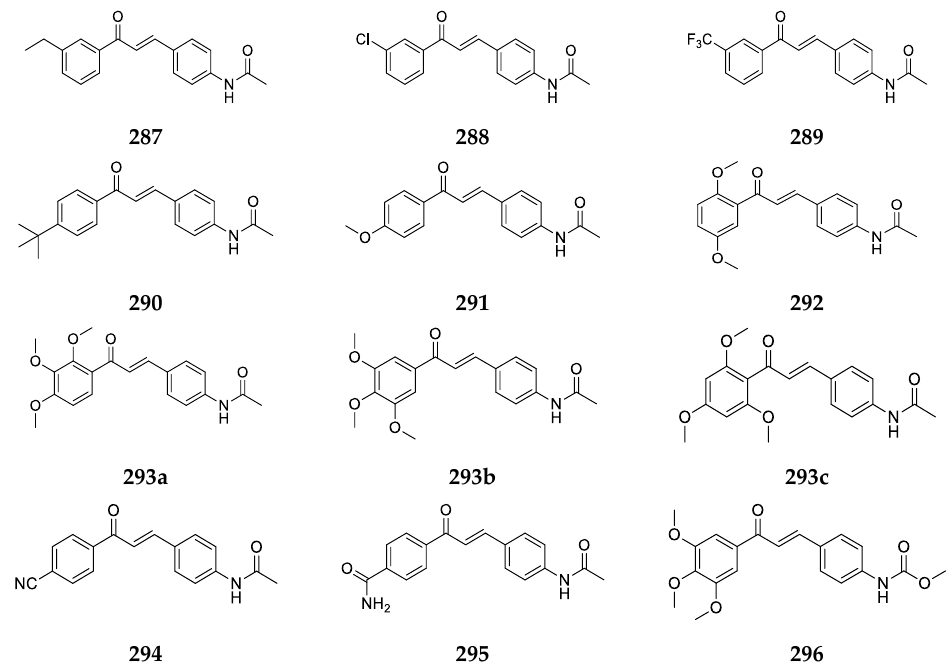
Figure 76. Chemical structure of N -acyl-4′-aminochalcone derivatives with substitution on ring A. Earlier, we have discussed -NH 2 -substituted and N -alkyl-aminochalcones from the same investigation. Similarly, the potential of compounds 287 – 296 as antimitotic agents was tested against HeLa cells. The activity of these compounds was reported as the equivalent dose (ED), which is the concentration of the compound found to be equivalent to 0.05 µg/mL colchicine. Table 35 represents the ED value of compounds 287 – 296 over 6 h [61]. Apart from the acetylation on nitrogen at position 4′, compound 62c has the same structure as 293b . Compound 62c has also been added as a reference compound in Table 35. Table 35. The concentration of compounds 287 – 296 giving the same mitotic index as colchicine (0.05 µg/mL), i.e., equivalent dose (ED) against HeLa cells exposed to the compounds for 6 h.